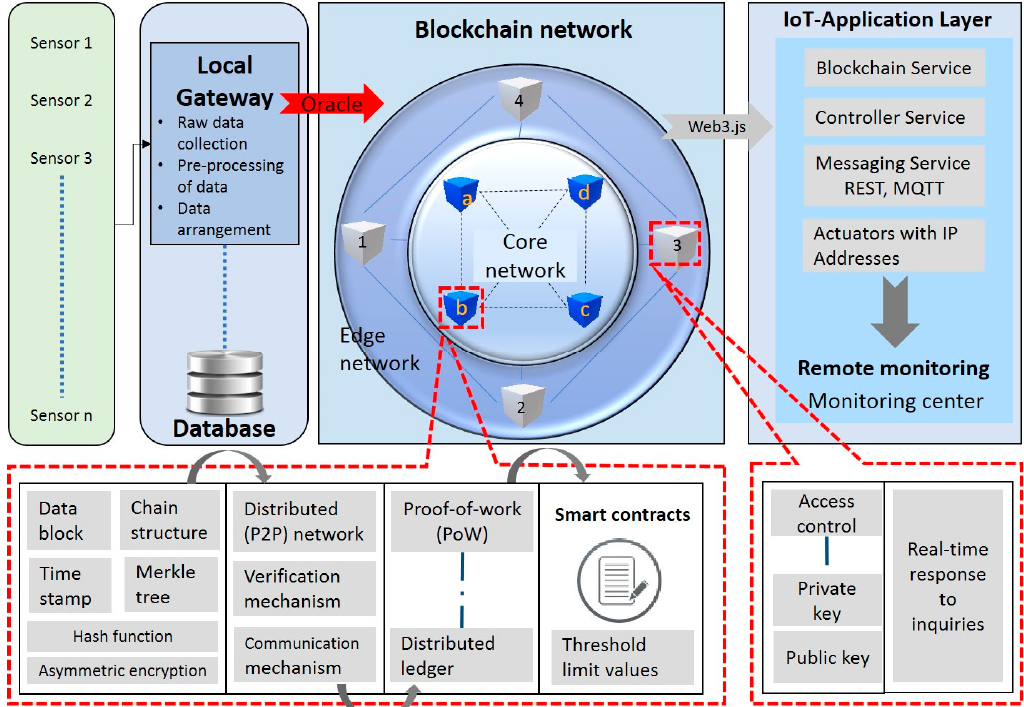
Figure 1. Proposed blockchain–Internet of thing (IoT) network architecture for structural health monitoring (SHM).